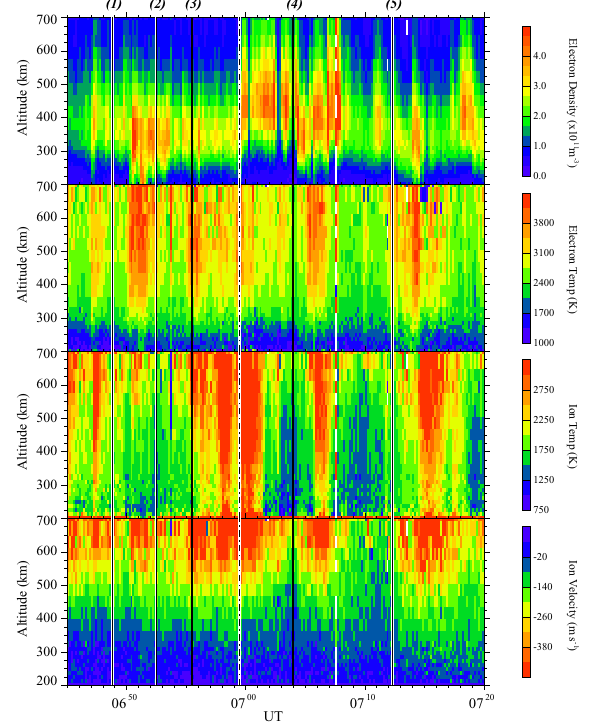
Fig. 5. Field-aligned observations from the ESR located at ∼ 75 ◦ magnetic latitude, between 06:45UT and 07:20UT. From top to bottom, the four panels show electron density ( N e ), electron tem- perature ( T e ), field parallel ion temperature ( T i ) and ion velocity ( V i ), presented as a function of height and analysed at 10-s reso- lution. The velocities are colour-coded in a similar fashion to the Doppler velocities shown in the middle panel of Fig. 4. Again, the vertical lines indicate the onset times of cusp-like precipitation iden- tified from the MSP data, numbered accordingly. The dot-dashed line at ∼ 06:59UT indicates a time where the ESR made observa- tions of particular interest (see comments in the